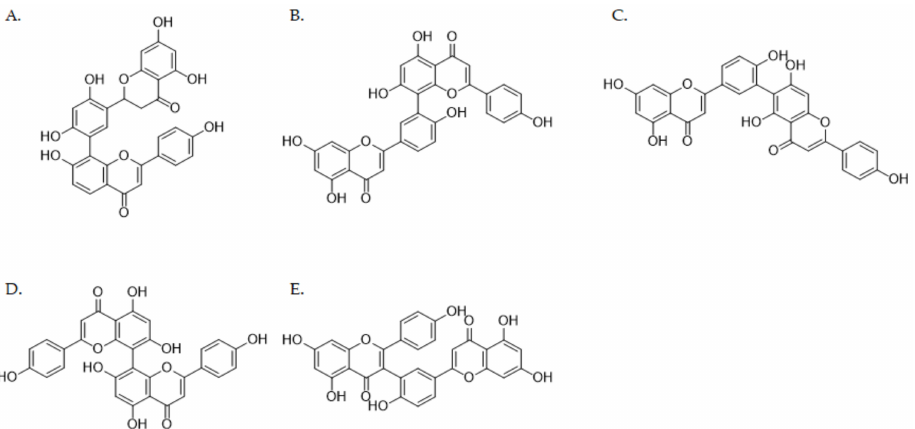
Figure 1. Chemical structures of biflavonoids from Selaginella tamariscina : selamariscina A ( A ), amentoflavone ( B ), robustaflavone ( C ), cupressuflavone ( D ) and taiwaniaflavone ( E